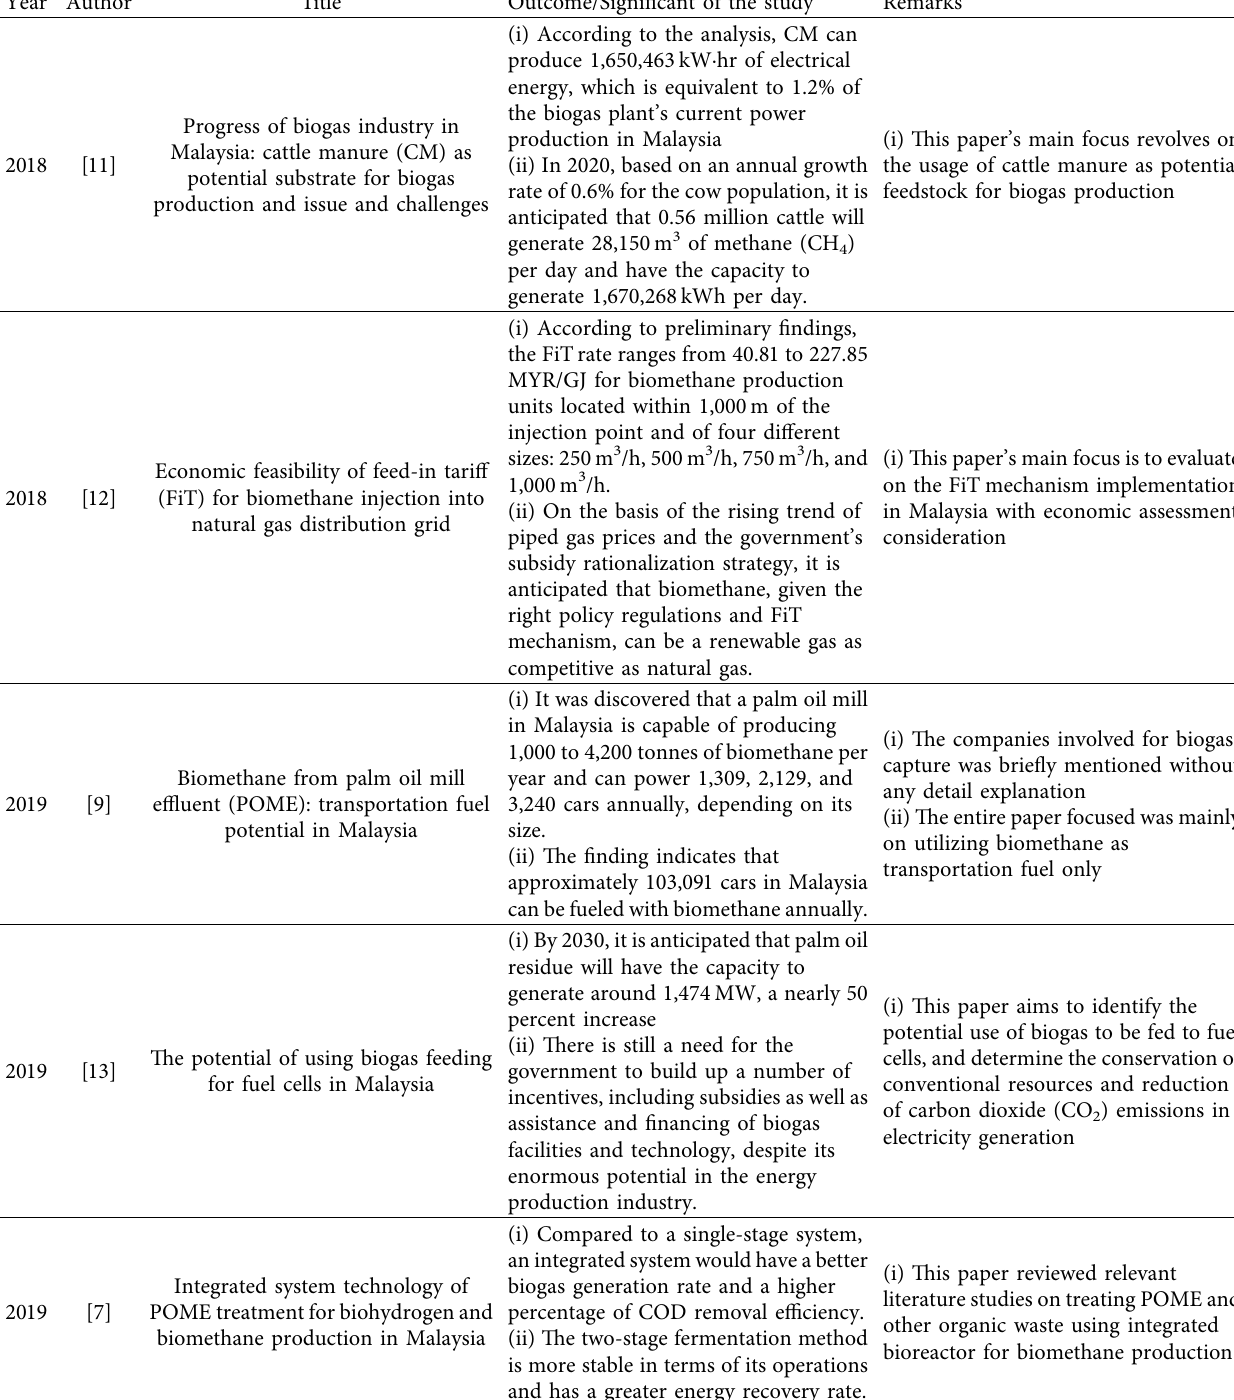
Table 1: State-of-the-art overview of the study conducted for Malaysia biomethane production (2018–2022) that includes the justification of conducting this